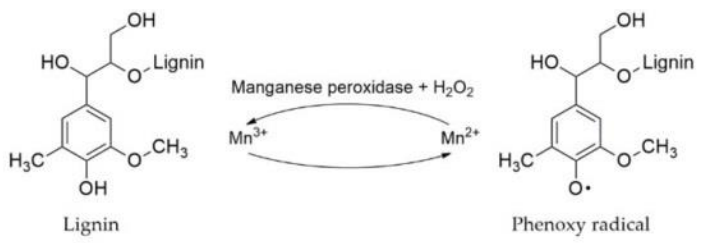
Figure 3. Lignin depolymerization with MnP